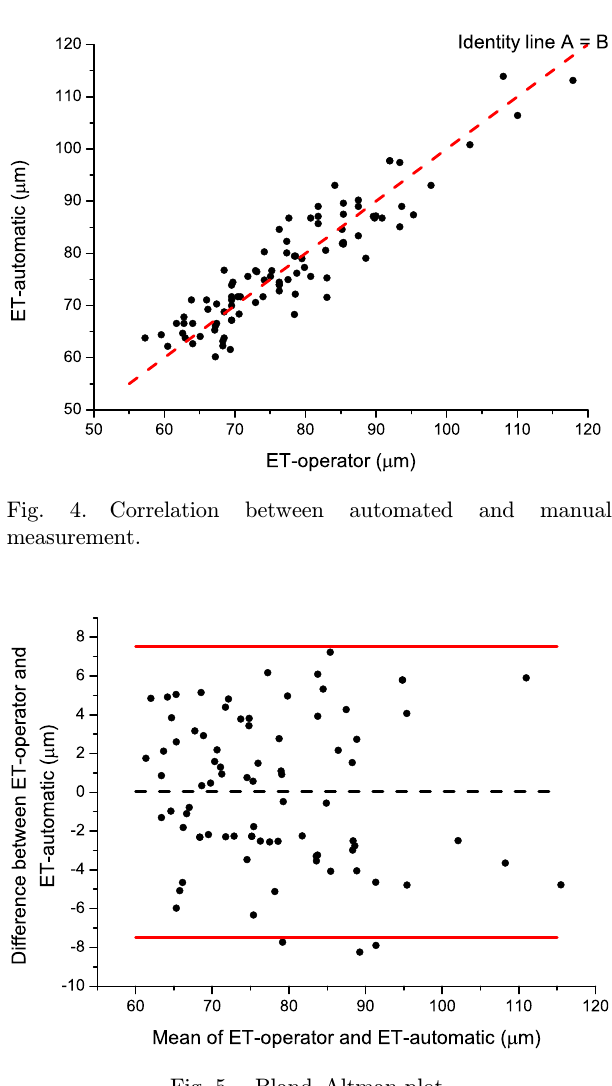
Fig. 5. Bland – Altman plot.